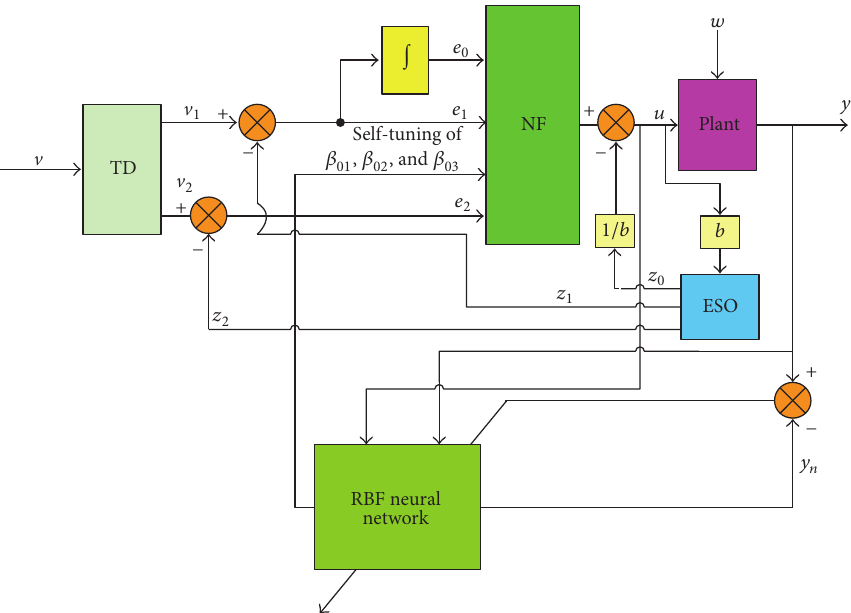
Figure 4: Control diagram of the RBF-ESO algorithm proposed in this paper.